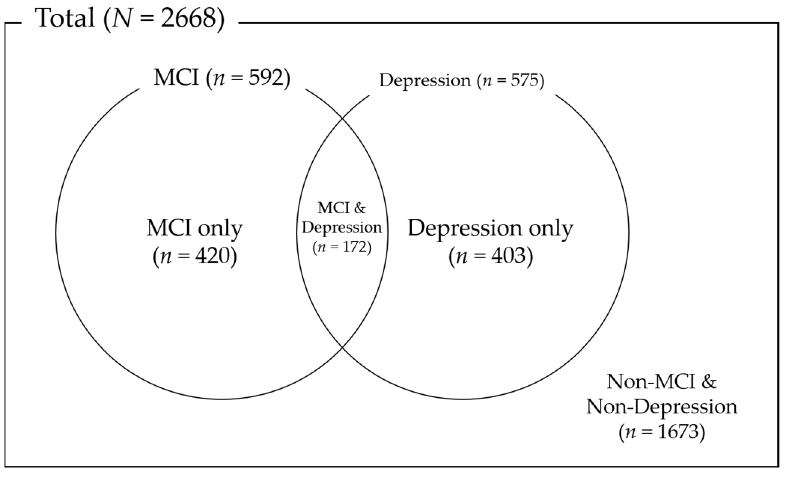
Figure 1. Distribution of MCI and depression.